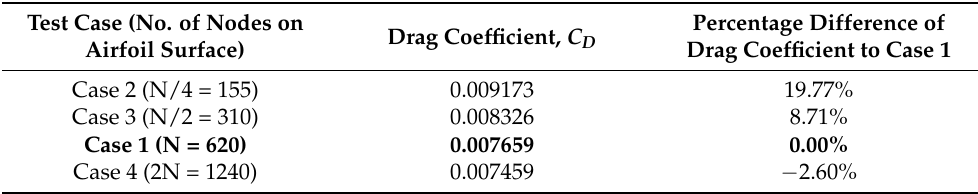
Table 1. Mesh convergence study. The drag coefficient for a different number of nodes on the airfoil surface for the Reynolds number of 4 × 10 6